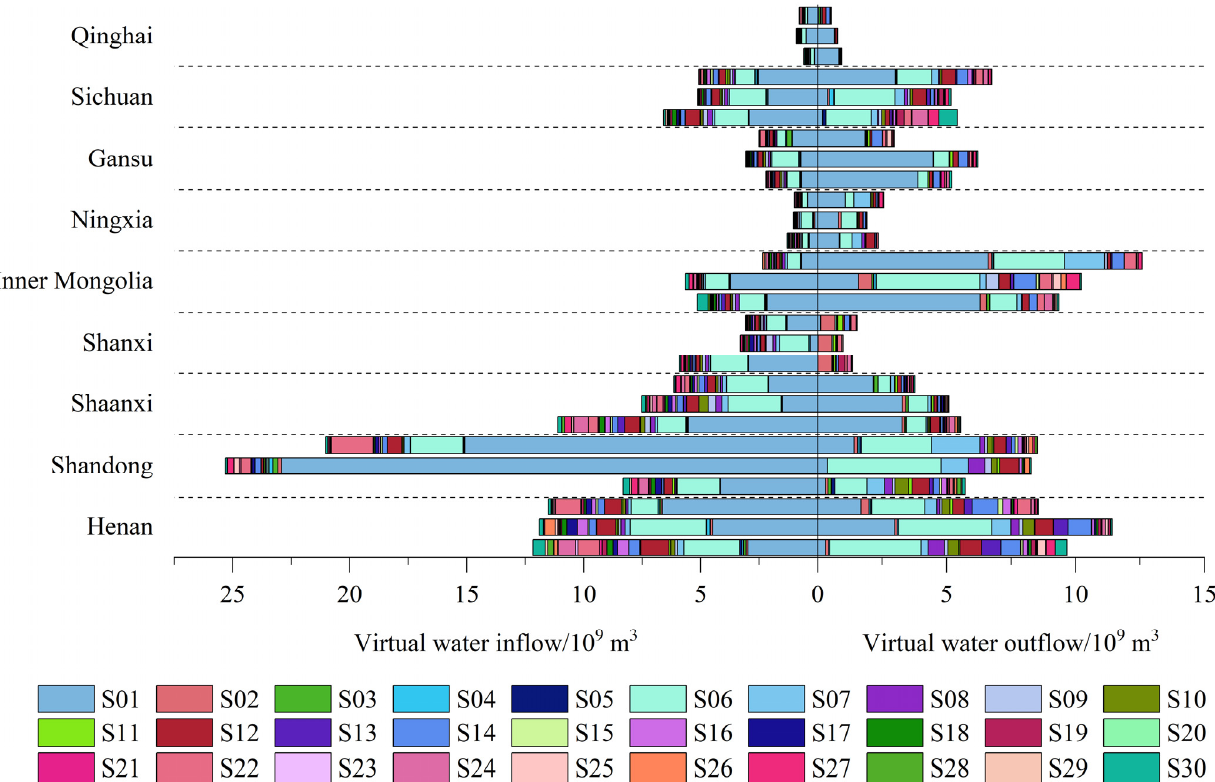
Figure 4. Virtual water inflows and outflows for thirty sectors of the nine provinces in the Yellow River basin, 2007–2017.